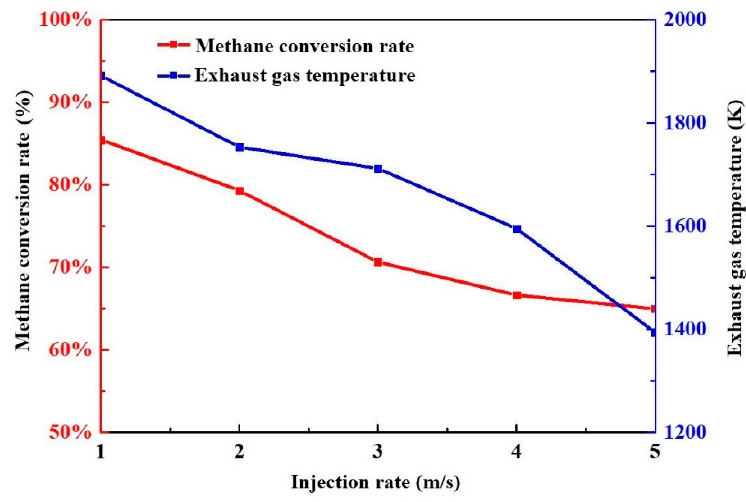
Figure 16. The influence of injection rate on conversion rate and exhaust gas temperature at 4 MPa.